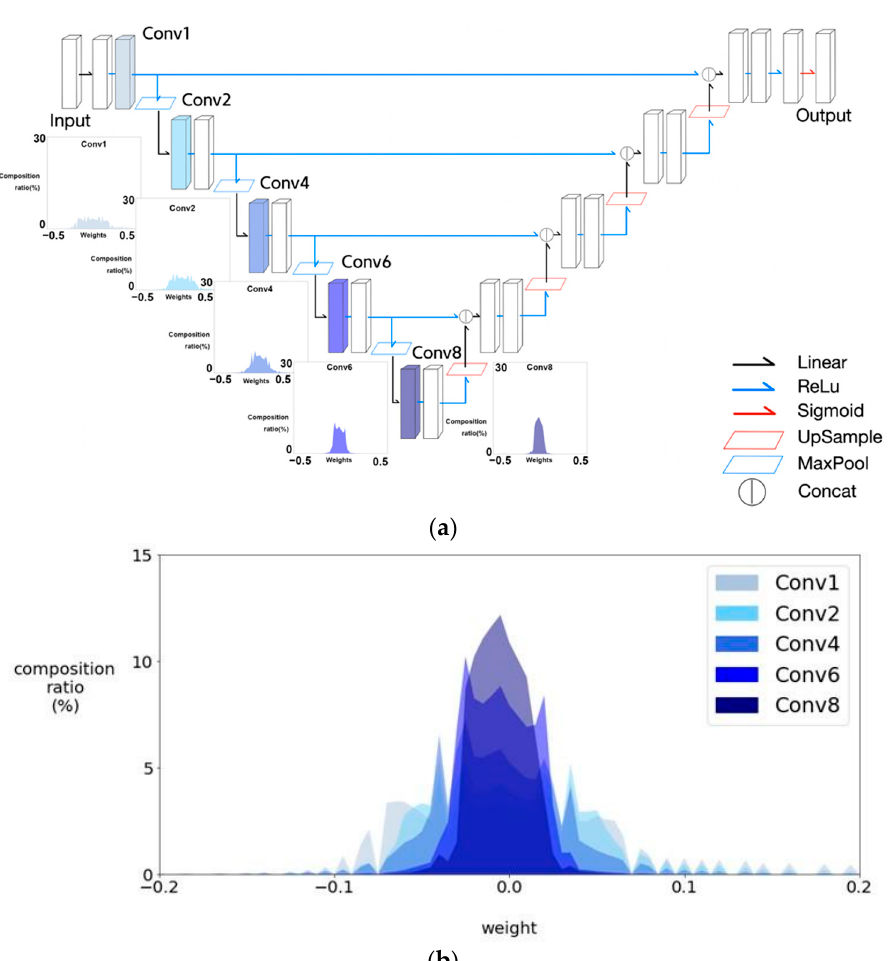
Figure 11. Kernel weights histograms of several encoder convolutional layers of U-net visualized using TensorBoard. ( a ) Weight histograms of specified convolutional layers with colors in U-net. ( b ) Overlapped weight histograms of specified convolutional layers.